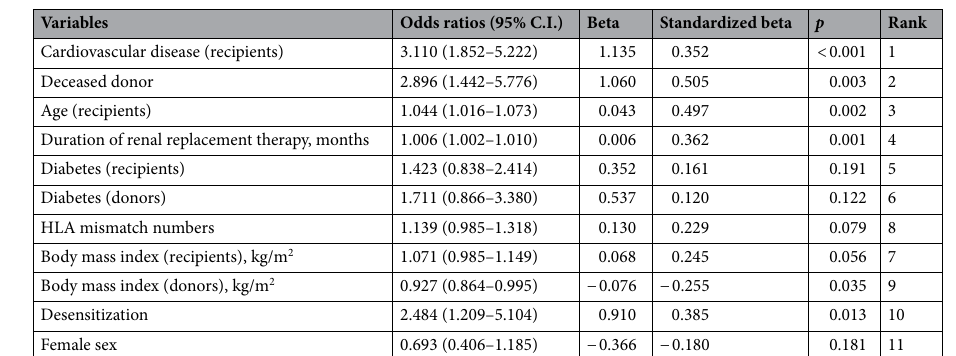
Table 4. Selected predictors to 1 year patient death and variable rank by dominance. HLA, human leukocyte antigen.